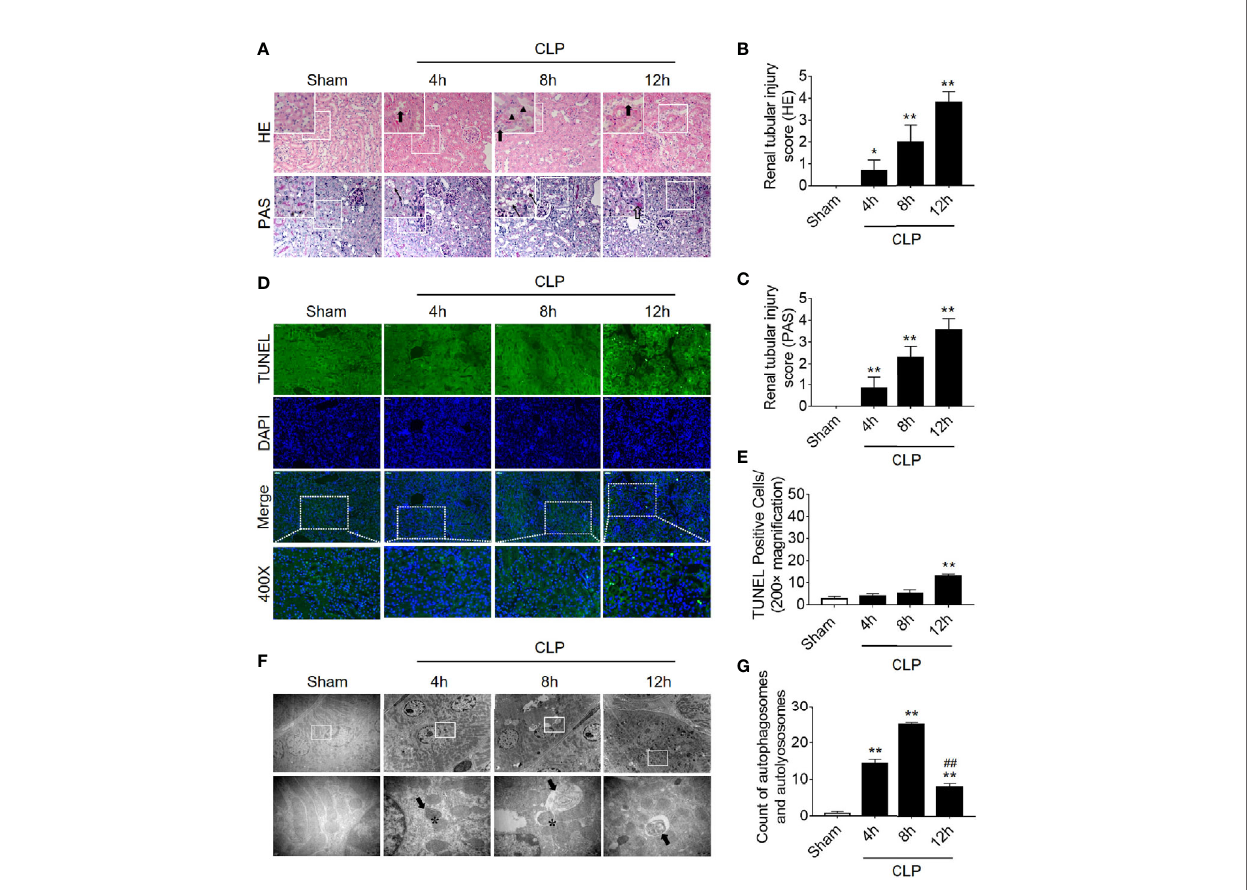
FIGURE 1 | Renal pathology score, apoptosis, and autophagy following CLP-induced sepsis. (A) Hematoxylin-eosin (HE) staining (upper panel: 200×; inset: 400×) and periodic acid-Schiff (PAS) staining (lower panel: 200×; inset: 400×) of the renal cortex following CLP-induced sepsis. Black thick arrows: Nuclei of RTECs shed to lumen; Long black arrows: tubular dilation; Black triangles: renal tubular casts; White thick arrows: severe tubular damage. (B, C) The tubular damage score was evaluated based on pathological observations from HE and PAS staining. * p < 0.05, ** p < 0.01 vs. sham group; n = 5. (D) Cell apoptosis of the renal cortex, as assessed by TUNEL-positive cell staining following CLP-induced sepsis. Upper panel: 200×; lower panel: 400×. (E) Semi-quantitative analysis of TUNEL-positive cells. ** p < 0.01 vs. sham group; n = 5. (F) Observation of autophagy in the renal cortex under transmission electron microscope following CLP-induced sepsis. Black thick arrows: autophagosomes or autolysosomes; Asterisk: mitochondrial autophagy; upper panel: magni fi ed ×7000; lower panel: magni fi ed ×40000. (G) Semi-quantitatively analysis of autophagy. The numbers of autophagosomes and autolysosomes in renal epithelial cells were calculated in 20 randomly selected fi elds. ** p < 0.01 vs. sham group; ## p < 0.01 vs. 8 h group; n = 20. CLP, cecal ligation and puncture; RTEC, renal tubular epithelial cell; TUNEL, terminal deoxynucleotidyl transferase dUTP nick-end